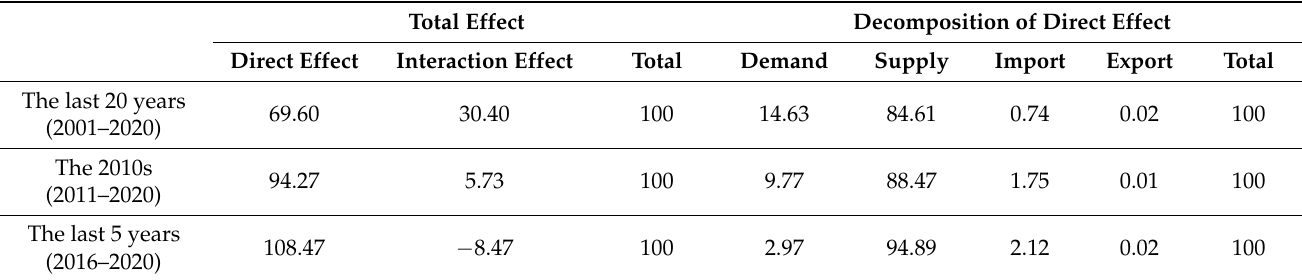
Table 7. Price fluctuation analysis results of garlic.